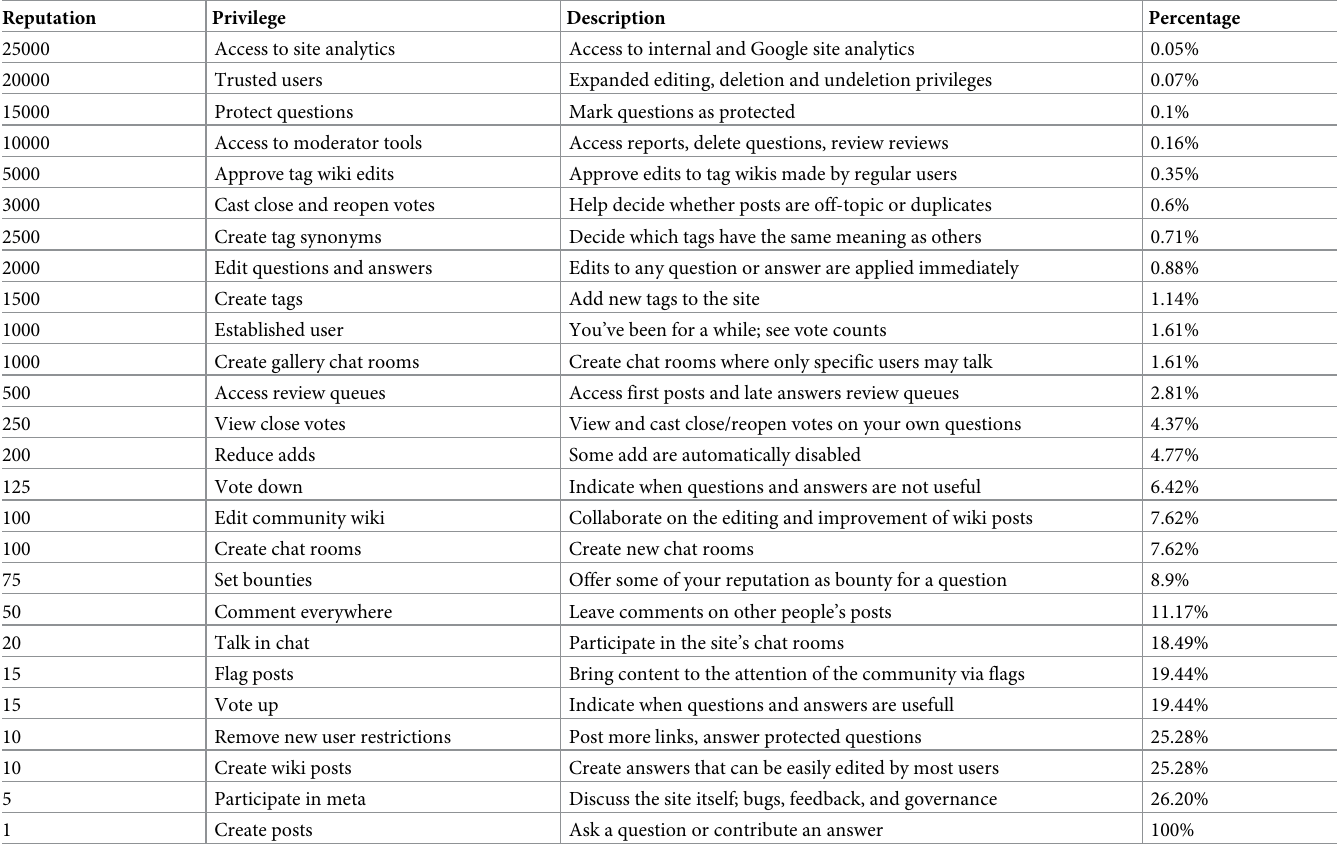
Table 1. Users distribution by Stack Overflow